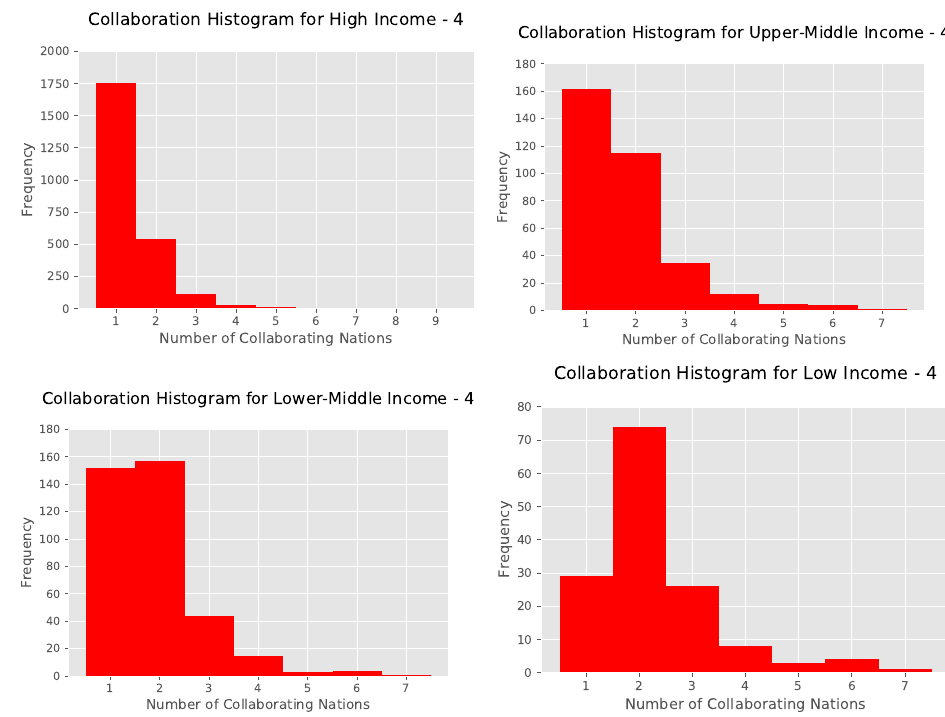
Figure 21. The distribution of distinct nations represented on papers in the agricultural and veterinary sciences by income